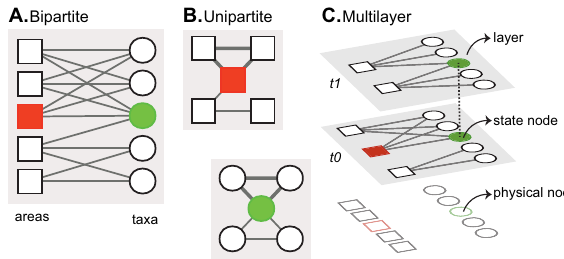
Fig. 1 Network models used in macroevolution. A , B Standard fi rst-order network representations. A Bipartite occurrence network. This representation comprises two sets of physical nodes that represent geographic areas and taxa 25 . B Unipartite co-occurrence networks 6,22 . These representations are weighted projections of the bipartite network onto each set of physical nodes. C Higher-order multilayer representation of temporal data. In this network, distinct state nodes represent a physical node in each layer where the physical node occurs 28 . The trajectory of a random walker, guided by the links between the nodes, models network fl ows 38 . Network fl ows are of fi rst order when random walker movements are constrained to single layers and of higher-order when they can move within and between layers 28 . The aggregation process that simpli fi es a multilayer network into a single-layer representation alters the network fl ows, obscuring the modular